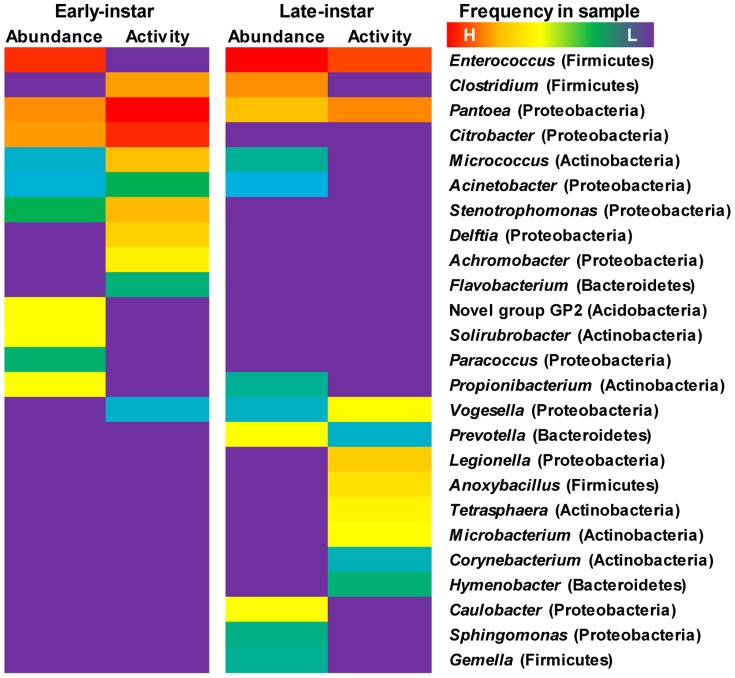
Frequency of 16S rRNA sequences in the microbiota obtained from the native-glucose control (bacterial relative abundance) and [13C]-glucose treatment (bacterial metabolic activity), represented as a heatmap.Left panel displays dynamic changes of taxa in early-instar larvae and right panel for late-instar. Warm colors indicate higher and cold colors lower abundance, calculated according to the formula in Fig. 2A (also see Fig. 5 for the percentage of taxa).